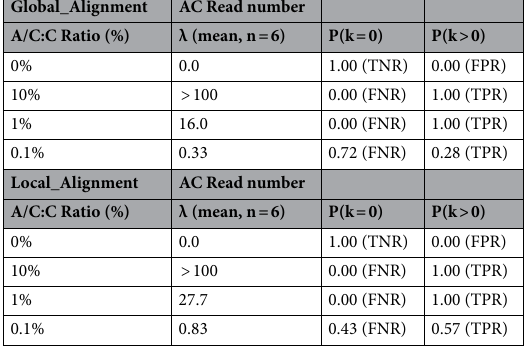
Table 4. True positive rates in detection of PERV-A/C intermingled with PERV-C. TNR: true negative rate, FPR: false positive rate, FNR: false negative rate, TPR: true positive